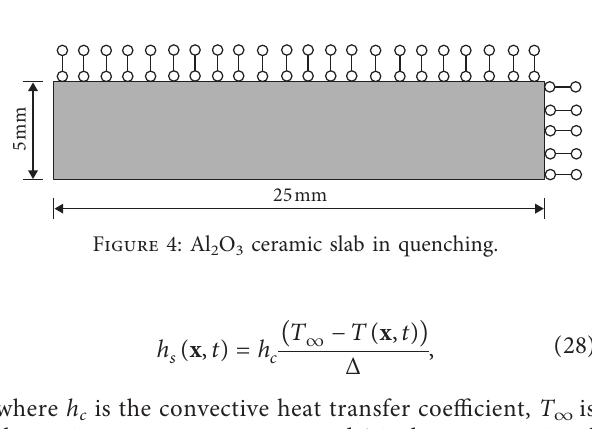
Figure 3: Peridynamic numerical algorithm for thermal cracking.